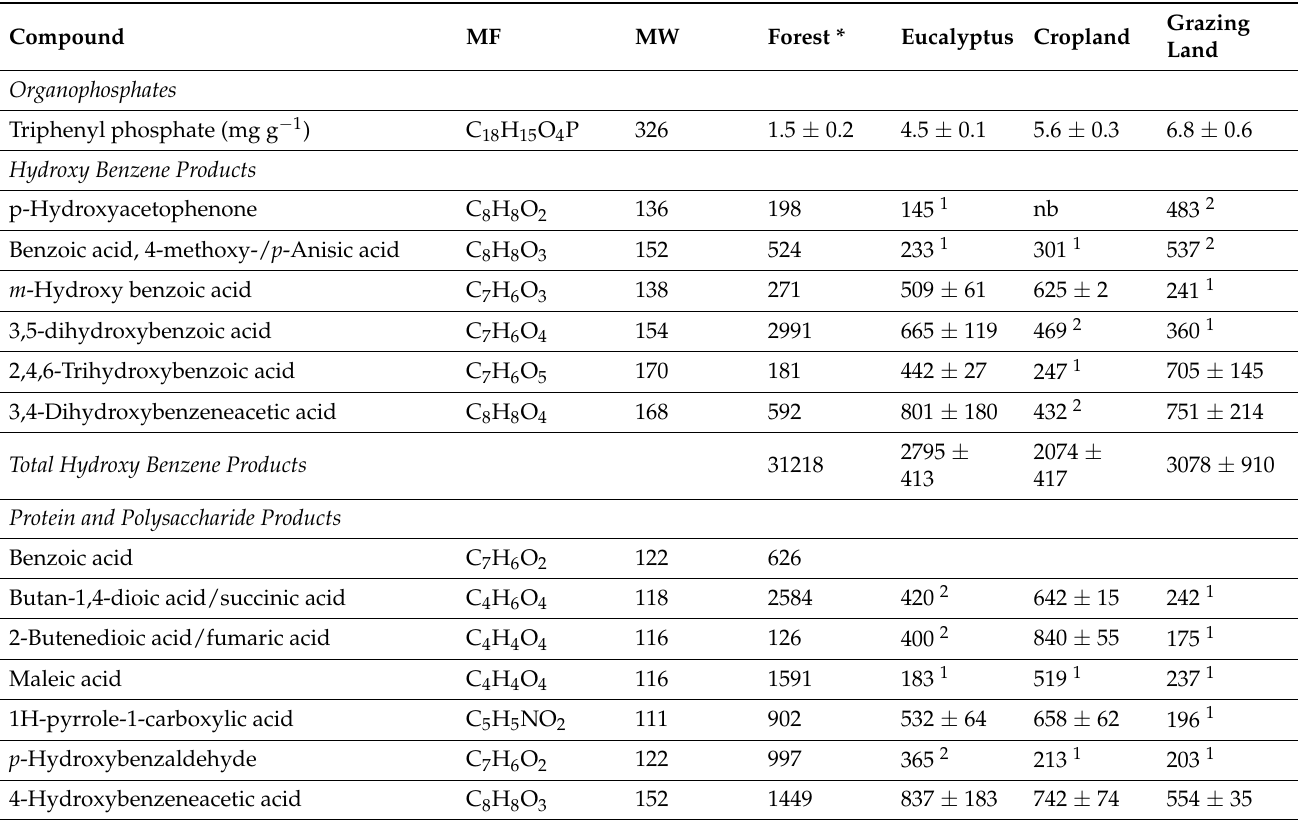
Table A3. Major compounds ( µ g g − 1 C) identified in the CuO oxidation extracts of soil samples from different land-use systems in Gelawdios, Ethiopia. MF, molecular formula; MW, molecular weight. Values are mean ± SE; n = 1–3 (see below